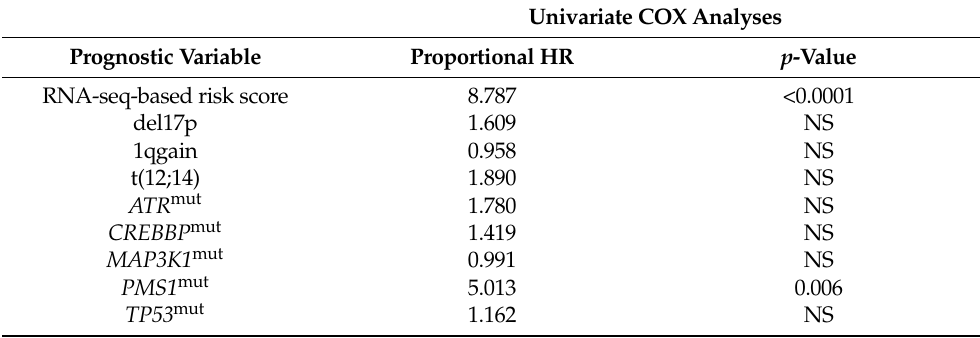
Table 1. Cox univariate and multivariate analyses to model overall survival in the CoMMpass cohort (n = 674 patients with MM) relative to the RNA-seq-based risk score, cytogenetic abnormalities.